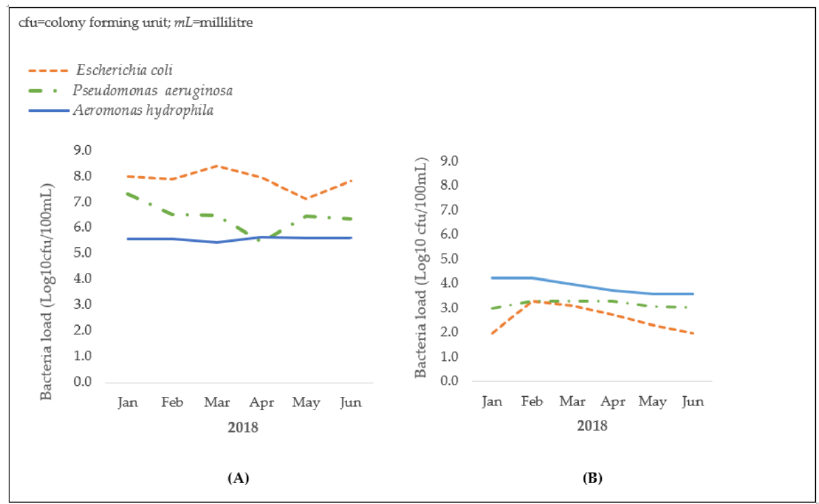
Figure 3. Bacterial loads in influent ( A ) and effluent ( B ) wastewater from the Legon Sewage Treatment Plant, Accra, Ghana (January to June